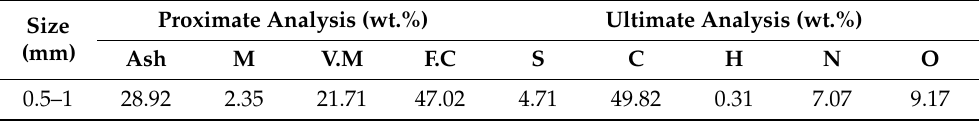
Table 1. Proximate analysis and ultimate analyses of Chinese high-sulfur raw